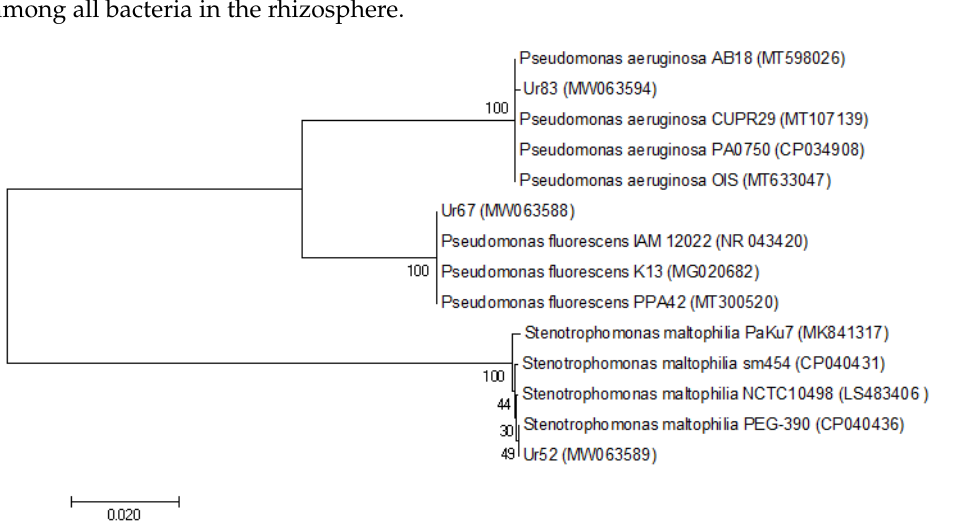
Figure 1. Neighbor-joining phylogenetic tree of 16S rDNA partial sequences from selected ten isolates. Sequences of the compared strains were obtained from databases, and the accession numbers are in parenthesis. Bootstrap values ( n = 1000 replicates) were indicated at the nodes.